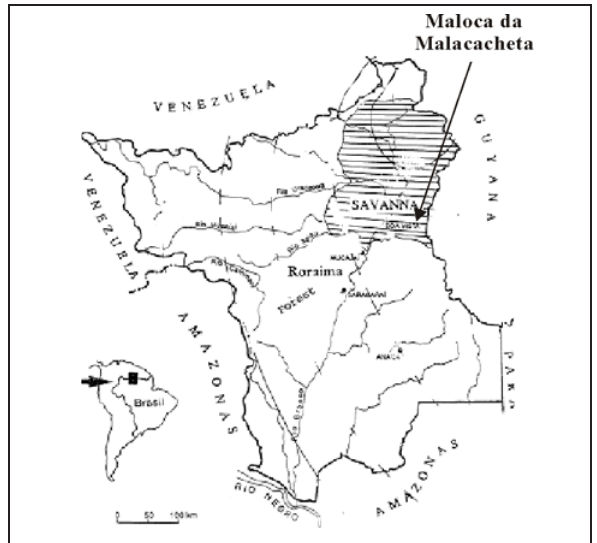
Figura 1. Localização do TI Malacacheta, no sudeste de